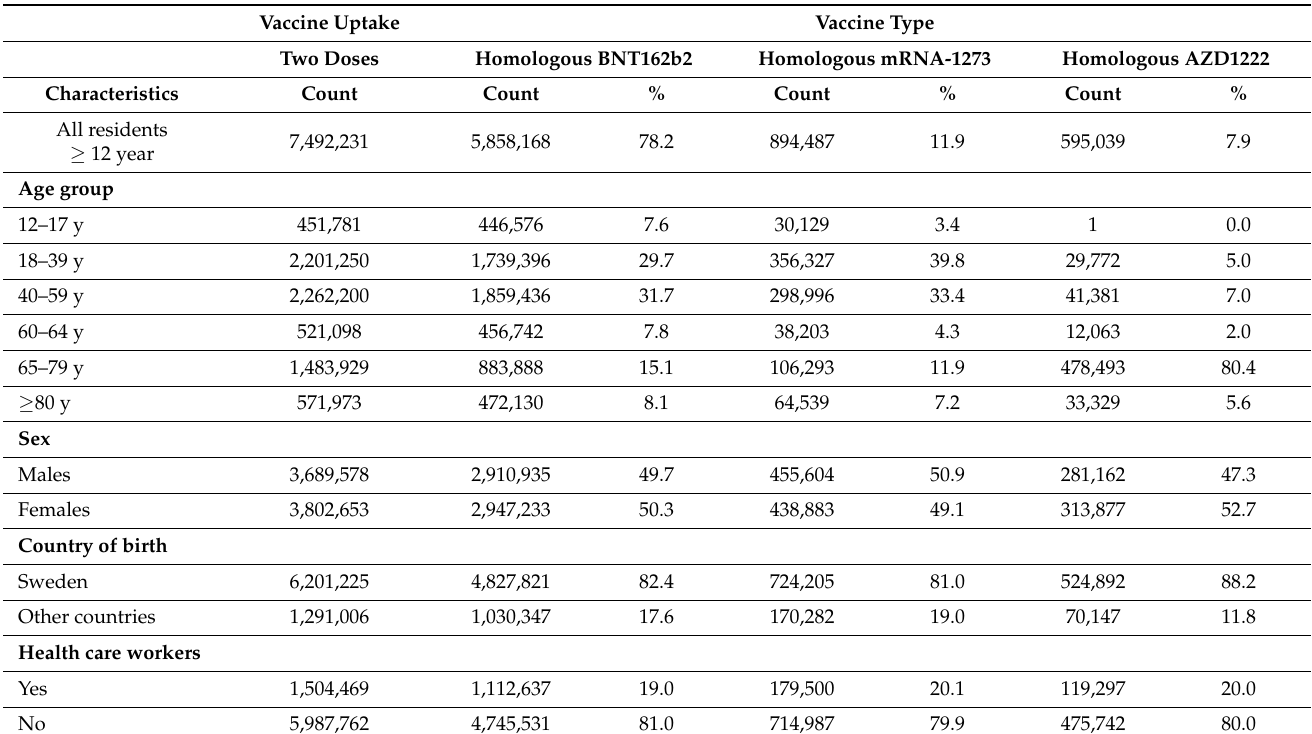
Table 2. Sociodemographic and comorbidity characteristics of people receiving two doses according to vaccine